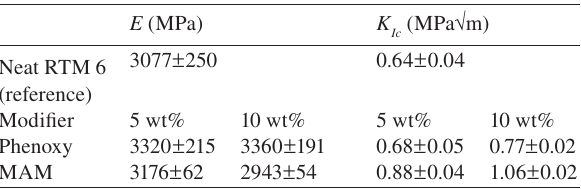
Table 1 Quasi-static LEFM testing of neat and modifi ed RTM6 ® epoxy resin systems.